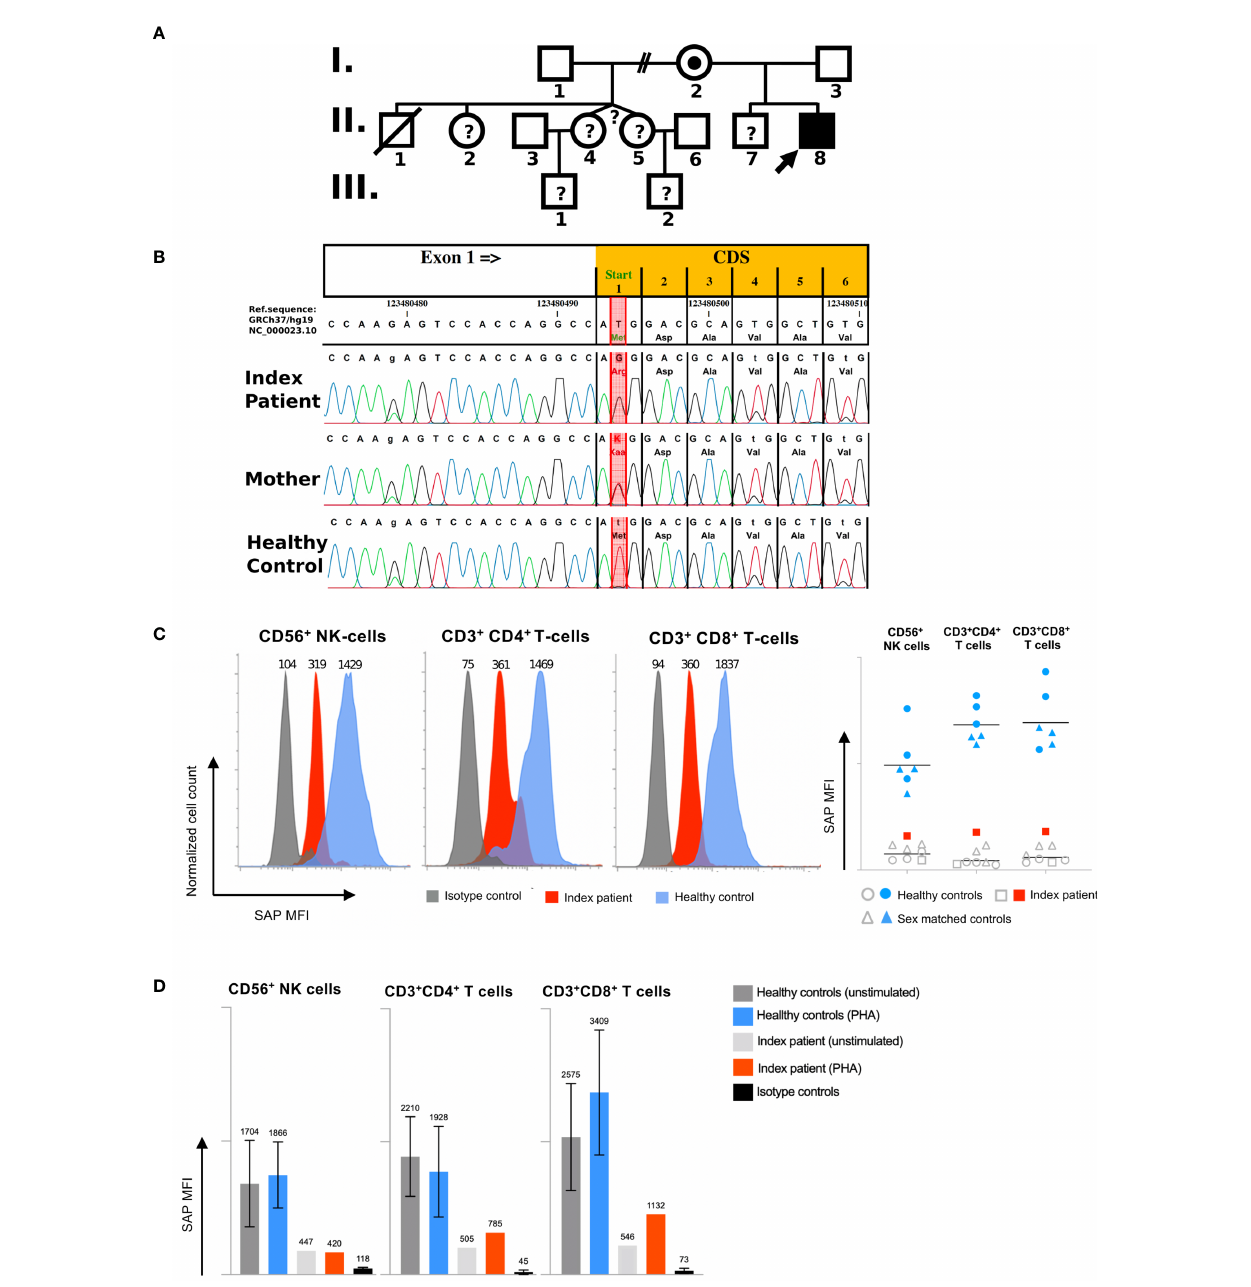
FIGURE 3 | Molecular and functional characterization of a novel SH2D1A mutation: (A) Family Pedigree. The arrow indicates the index patient. Mutation analysis con fi rmed a hemizygous SH2D1A mutation in patient II,8 and female carrier status in his mother I,2. One half-brother died at the age of 3 from acute leukaemia after suspected EBV infection (II,1), without con fi rmation of the XLP1 genotype by sequencing. No genetic analysis could be performed in other family members (indicated by question marks). (B) Results of Sanger sequencing of SH2D1A of the index patient, the mother and a healthy male individual are shown. Red column indicates position of the start codon mutation (ChrX:g.123480494 T>G; GRCh37/hg19). (C) Intracellular SAP expression due to novel SH2D1A mutation. Mean fl uorescence intensities (MFI) representing intracellular SAP expression in CD56 + NK-cells, CD4 + T-cells, and CD8 + T-cells of one representative healthy control (blue), and the index patient (red) are shown in histograms (isotype control staining is shown in grey). Diagram of MFI representing SAP expressions of six healthy controls consisting of 3 male sex matched controls (shown as blue triangles) and 3 anonymous blood donors (shown as blue dots), the index patient (shown as red squares) and relating isotype control staining (shown as grey rings, triangles and squares) are shown in the right fi gure (lines represent geometric mean). (D) Quanti fi cation analysis of intracellular SH2D1A expression. MFI of intracellular SH2D1A expression in CD56 + NK-cells, CD3 + CD4 + T-cells and CD3 + CD8 + T-cells from fi ve healthy controls including 3 male sex matched controls and 2 anonymous blood donors as well as the SH2D1A-de fi cient index patient following 3 days of PHA (phytohemagglutinin)-stimulation are shown (bars and top numbers represent mean values, error indicators represent standard deviations, staining of isotype controls are shown in